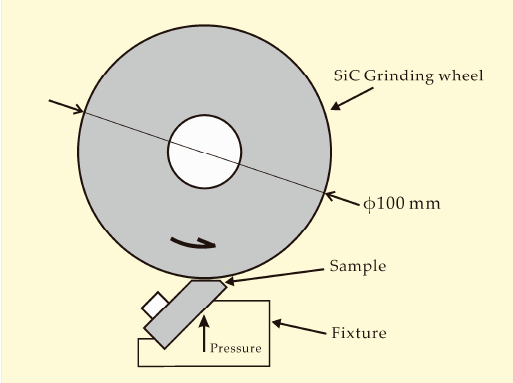
Figure 1. Schematic diagram of the grinding ratio test. Grinding wheels made of 80 mesh SiC grits are applied. The test parameters involved are: linear velocity 15 m/s, pressure load 500 g, and the sizes of samples range in 20 × 8 × 5 mm 3 .